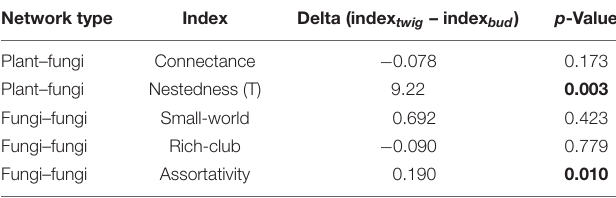
TABLE 2 | Statistical comparison of differences in network indices between plant organs, based on the analyses of plant–fungi networks and fungi–fungi networks. Network type